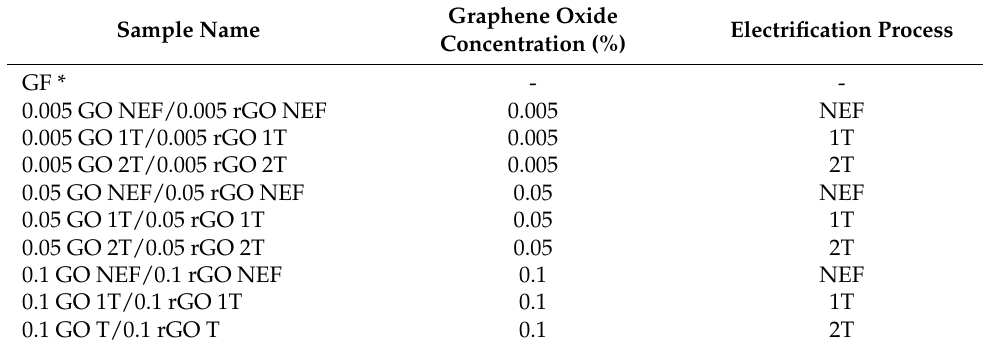
Table 1. Uncoated and coated fibers